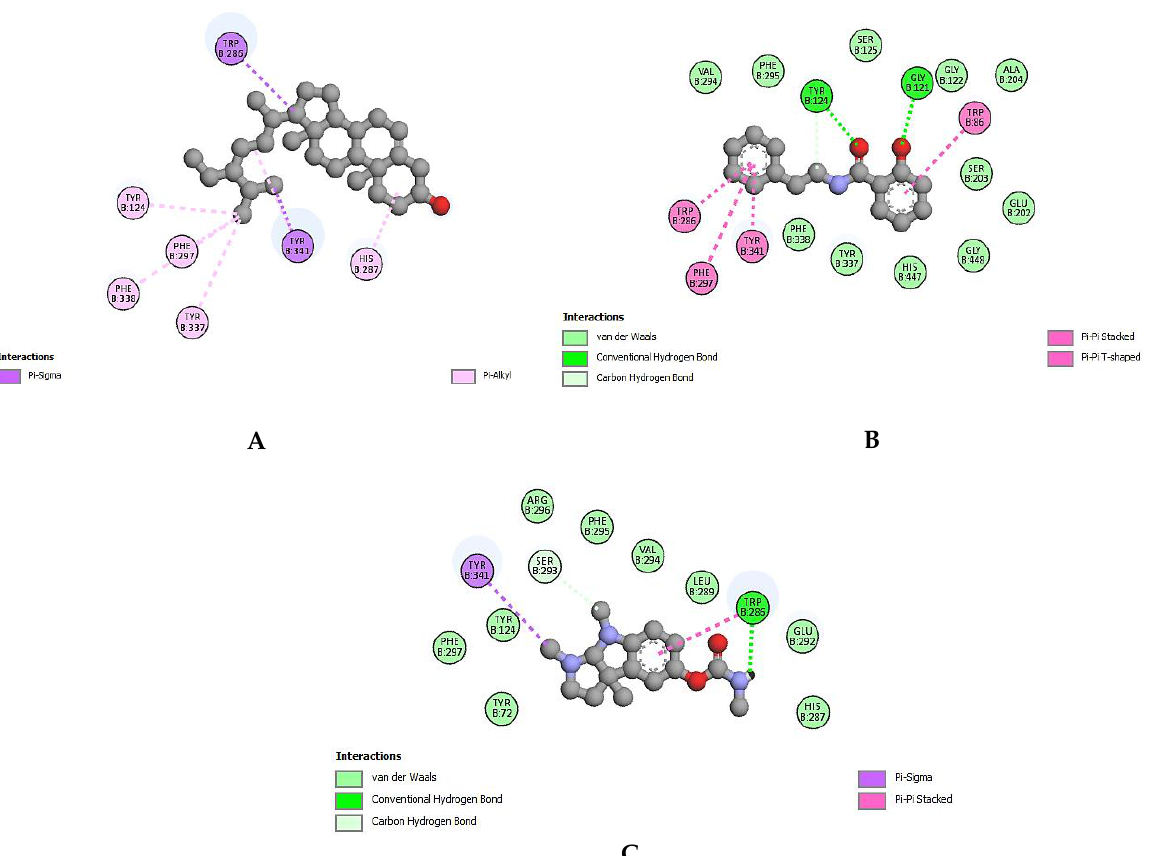
Figure 2. Interaction between acetylcholinesterase and ligands. ( A ) γ -sitosterol, ( B ) 2-hydroxy-n-(2- phenylethyl) benzamide, and ( C ) Eserin (standard).